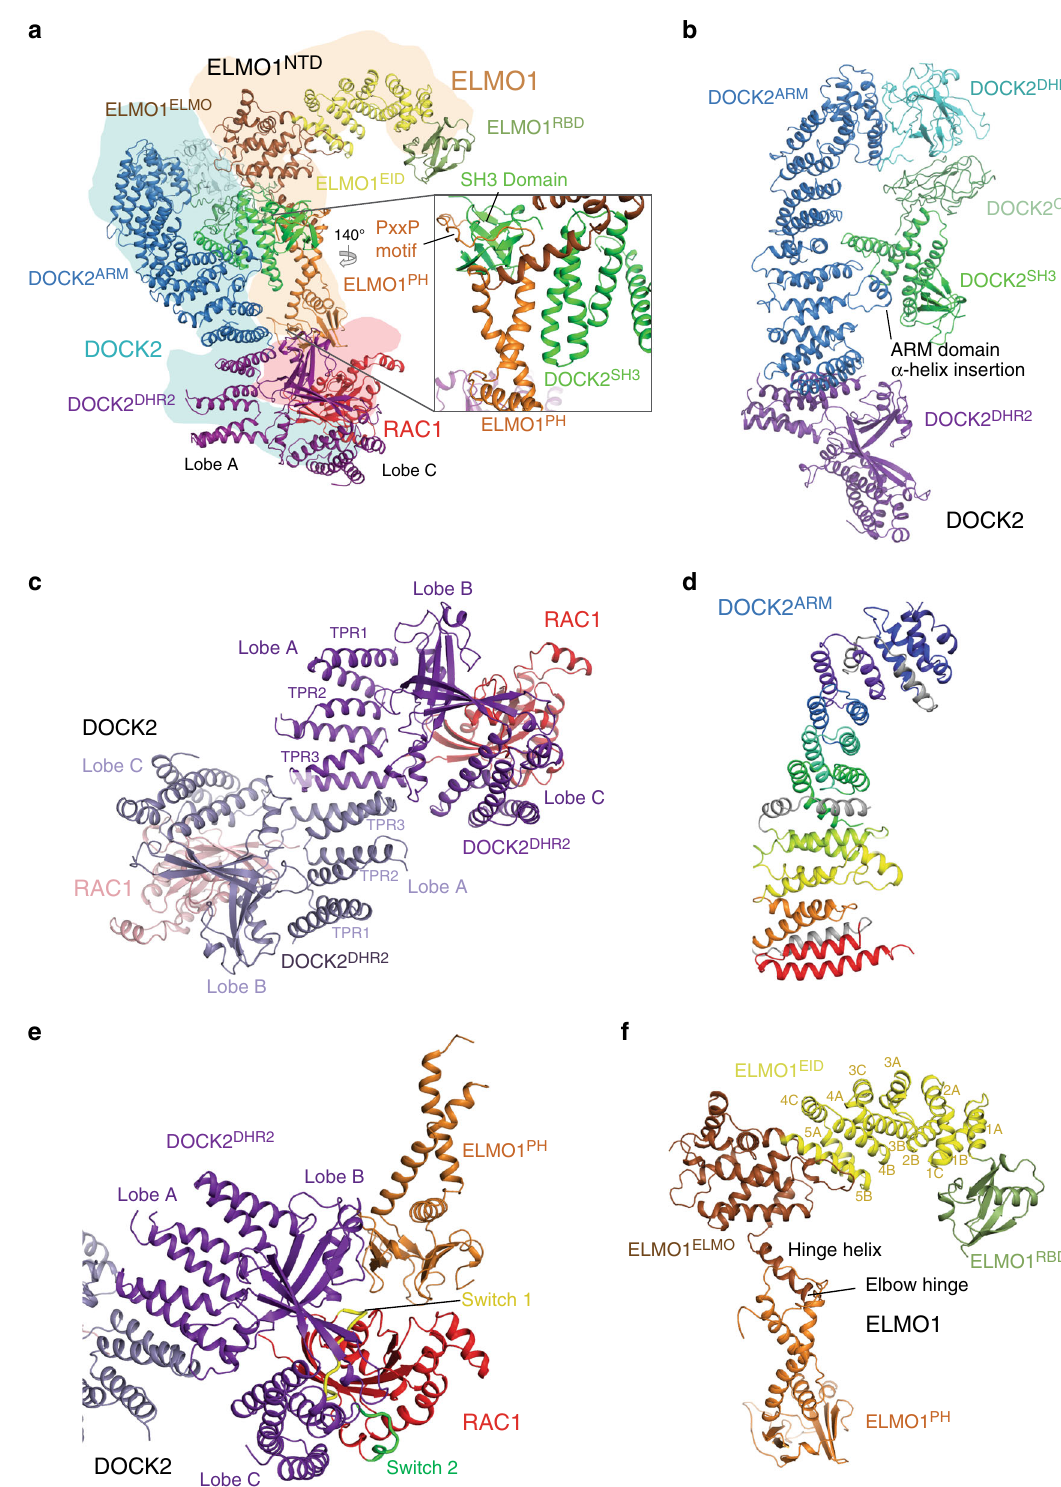
Fig. 2 Structure of the DOCK2 – ELMO1 – RAC1 protomer. a Ribbon representation of the structural assembly of the DOCK2 – ELMO1 protomer. DOCK2, ELMO1 and RAC1 are highlighted in cyan, yellow-orange and red backgrounds, respectively. Insert shows the major stable interface between DOCK2 and ELMO1 involving the six α -helical bundle. b Ribbon representation of DOCK2. Domains are labelled and colour-coded according to the domain scheme in Fig. 1a. c Close-up view of the dimer interface formed by lobe A of the DHR2 domains of each DOCK2 monomer (shown in purple and grey-blue). Lobe A, B and C of the DOCK2 DHR2 domains are labelled. d DOCK2 ARM is rainbow-coloured from blue (N-terminus) to red (C-terminus). e Close-up view of the interaction interface between DOCK2 DHR2 , ELMO1 PH domain and RAC1. The switch 1 and switch 2 loops of RAC1 are coloured in yellow and green, respectively. f Ribbon representation of ELMO1 colour-coded according to Fig.